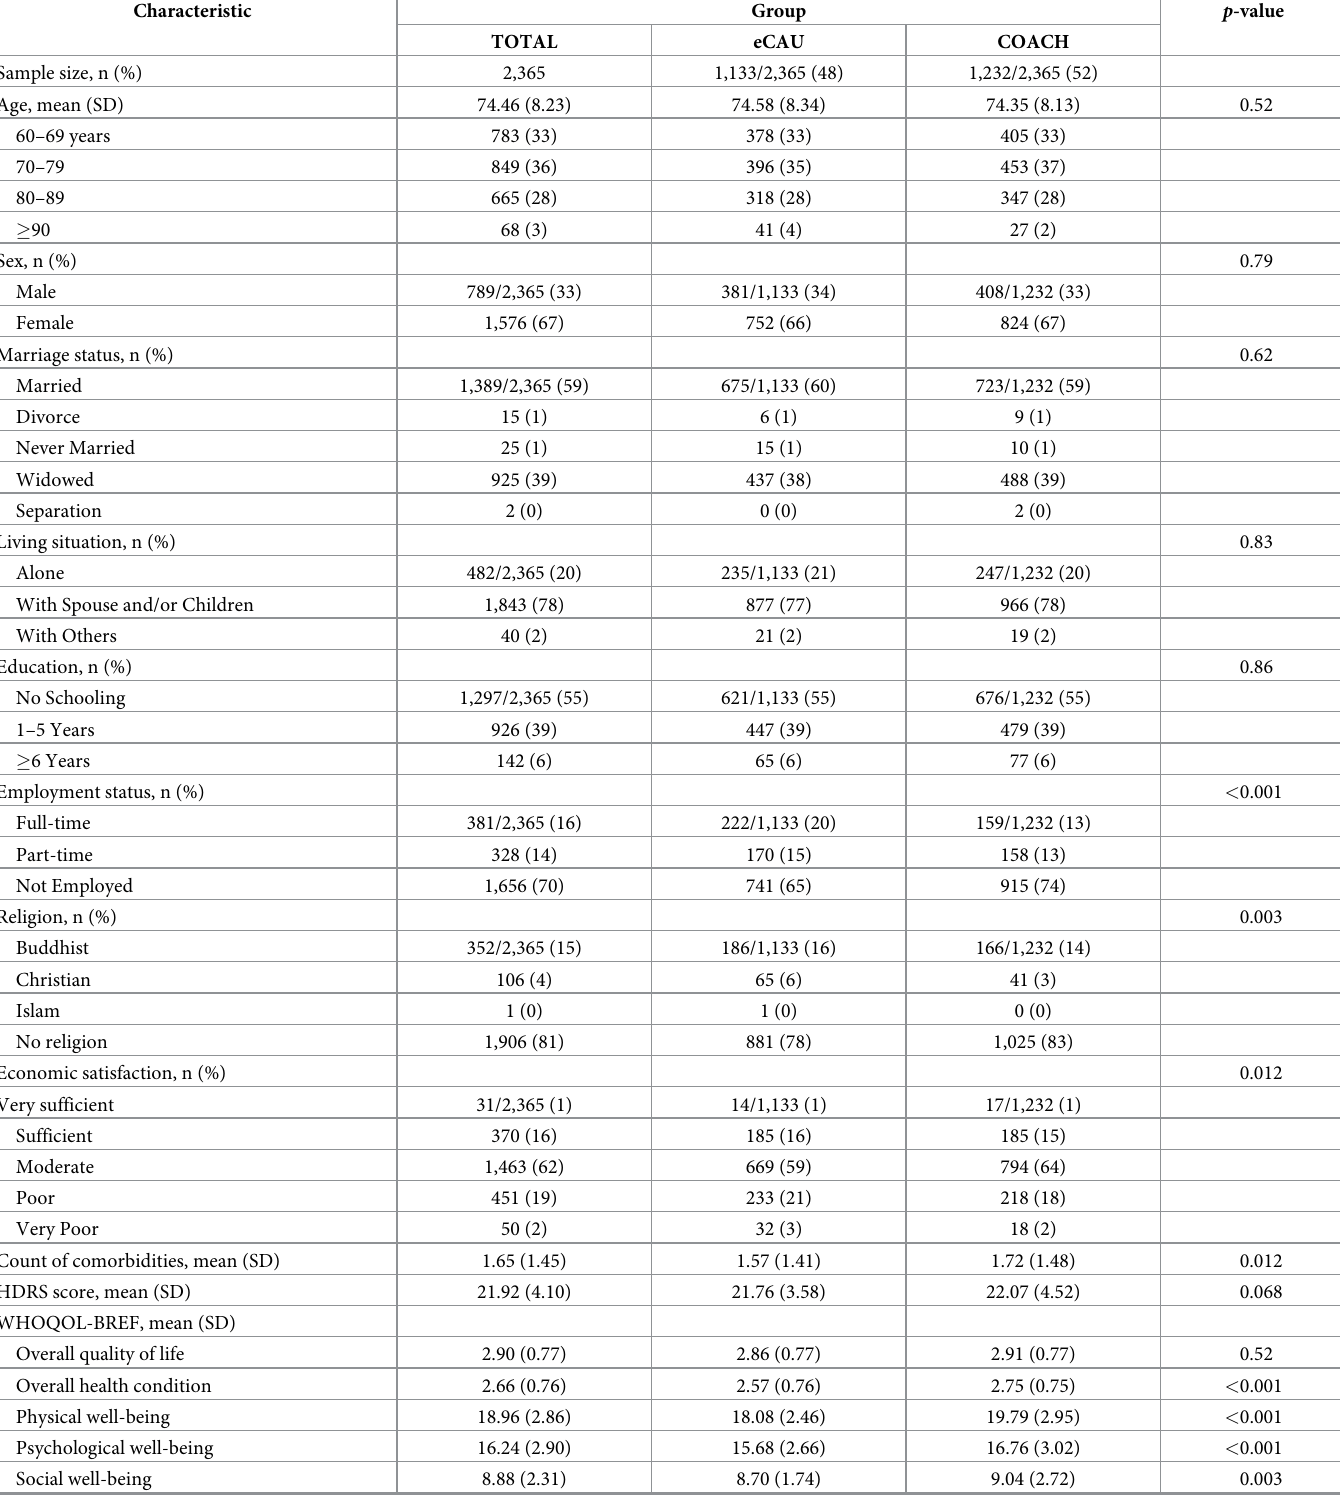
Table 1. Demographic and clinical characteristics of participants at baseline ( N =